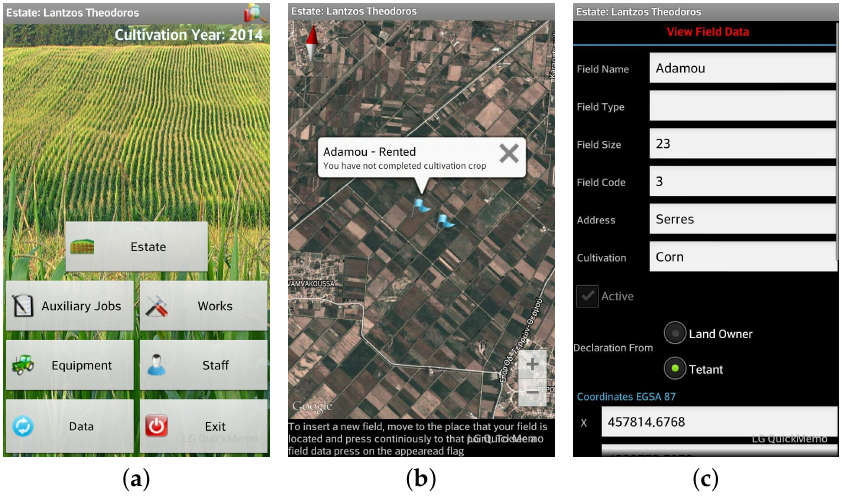
Figure 37. FarmManager: ( a ) Main menu; ( b ) Field definition and overview; ( c ) Field data